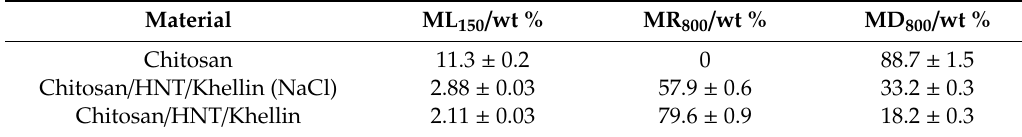
Table 3. Thermogravimetric parameters of Chitosan and Chitosan/HNT/Khellin samples.